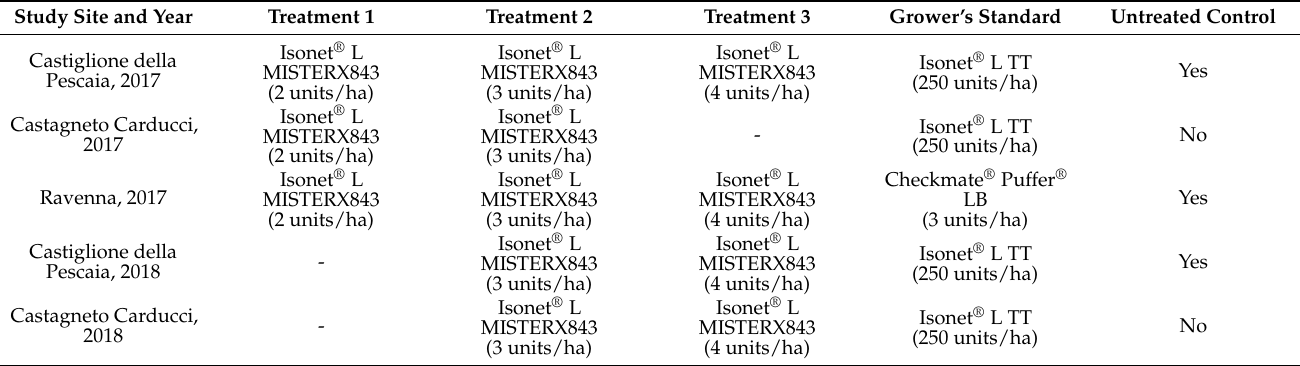
Table 3. Treatments tested in the various study sites (ha =